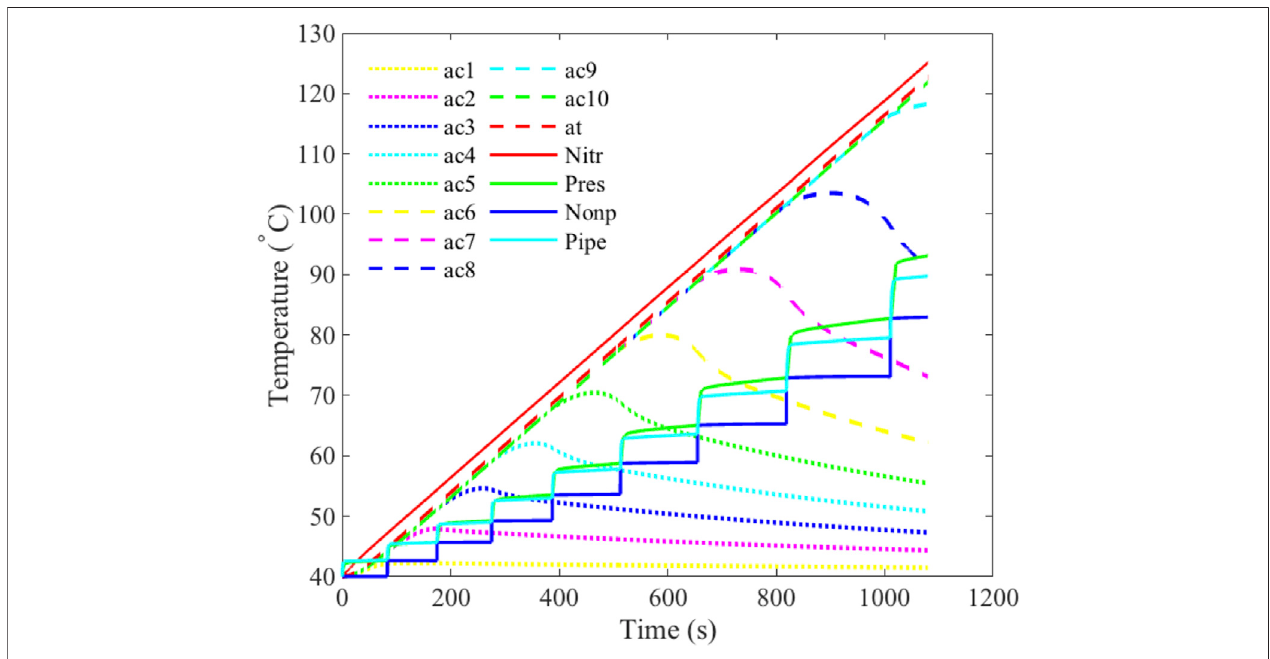
FIGURE 7 | Thermal characteristics of IHESS in the simpli fi ed cycle.